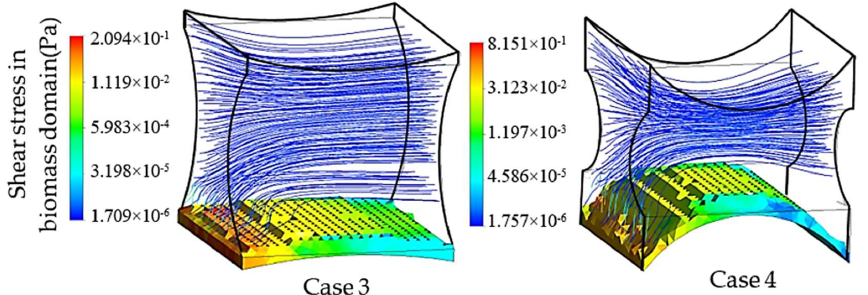
Figure 8. Hydrodynamic effect of the fiber location on the cell culture with initial cell density = 5 × 10 7 cells/cm 3 in the biomass phase, inlet velocity = 3 mm/s and inlet glucose concentration = 4.5 × 10 −3 g/cm 3 , 𝐷 (cid:2869)(cid:3030)(cid:3028)(cid:3046)(cid:3032)(cid:2871) = 520 μm , 𝐷 (cid:2870)(cid:3030)(cid:3028)(cid:3046)(cid:3032)(cid:2871) = 340 μm and 𝐷 (cid:2869)(cid:3030)(cid:3028)(cid:3046)(cid:3032) = 250 μm , 𝐷 (cid:2870)(cid:3030)(cid:3028)(cid:3046)(cid:3032) = 145 μm .